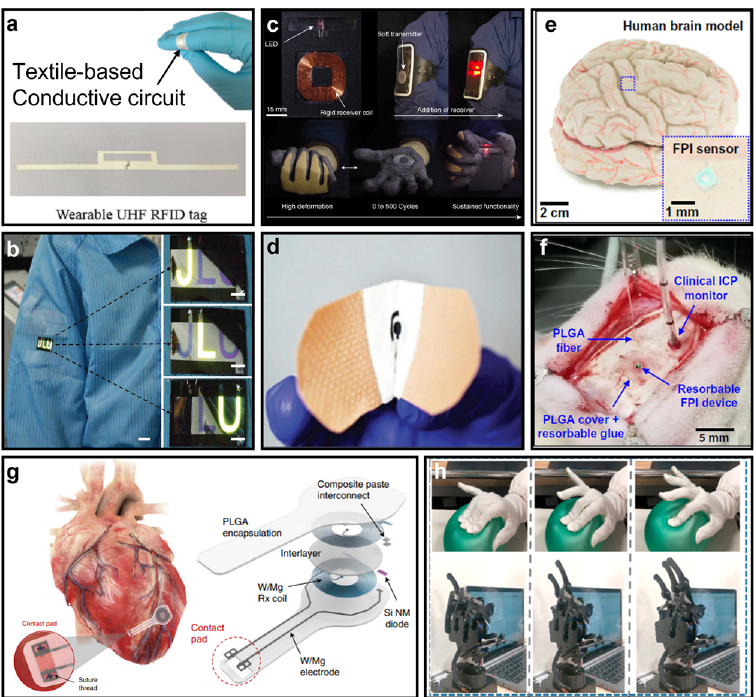
Figure 6. ( a ) Ultraviolet-curable nanomaterial-based on-skin RFID (reprinted with permission from Ref. [100], Copyright 2019 American Chemical Society). ( b ) Nanomaterial-enabled wearable display (reprinted with permission from Ref. [103], Copyright 2020 John Wiley & Sons, Inc.). ( c ) Wearable wireless power transfer enabled by a hybrid of magnetic colloidal and soft elastomers (reprinted with permission from Ref. [106], Copyright 2020 American Chemical Society). ( d ) Smart bandage achieved by soft material (reprinted with permission from Ref. [108], Copyright 2018 John Wiley & Sons, Inc.). ( e ) A bioresorbable nano-pressure sensor made with a Fabry–Pérot interferometer (FPI) structure attached to a human brain model. ( f ) Photograph of an FPI sensor implanted in the intra- cranial space of a rat. (( e , f ) Reprinted with permission from Ref. [36], Copyright 2019 The American Association for the Advancement of Science). ( g ) A nanomaterial-based peacemaker that is free of leads and batteries (reprinted with permission from Ref. [111], Copyright 2021 Springer Nature). ( h ) Human–machine interactions enabled by a nanomaterial-based pressure transducer (reprinted with permission from Ref. [112], Copyright 2020 American Chemical Society).